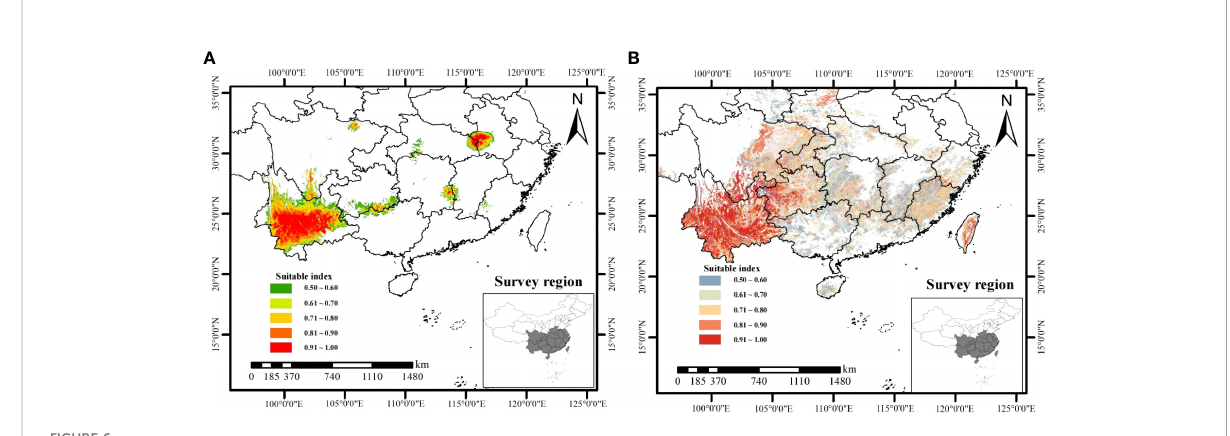
FIGURE 6 Prediction of (A) climate and (B) soil suitable habitat for W. cocos